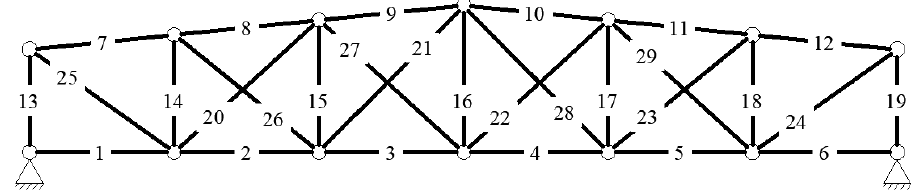
Figure 8. The numbering of rods in truss “B” after first reduction.